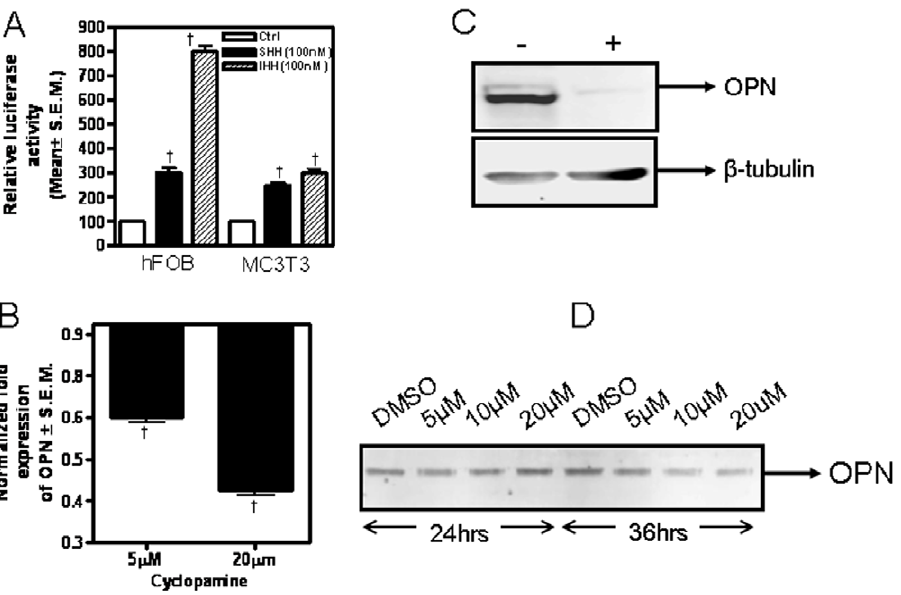
Figure 3. Hh signaling regulates OPN expression in osteoblastic cells. ( A ) Hh ligands significantly increase the activity of OPN promoter in the preosteoblastic cell lines hFOB 1.19 and MC3T3 E1 Sc-14 ( { indicates p , 0.0001 for all indicated groups). Cells were transfected with OPN promoter, treated with Hh ligands at the indicated concentrations and assessed for luciferase activity. ( B ) The Hh pathway inhibitor, cyclopamine (20 m g/ml), decreased the expression of OPN transcript ( { indicates p , 0.0001). hFOB 1.19 cells were treated with cyclopamine for 24 hours and assessed by quantitative real time RT-PCR for OPN expression. The expression of total OPN, from the cell lysate ( C ) as well as secreted OPN ( D ) is decreased in presence of cyclopamine. The decrease in the secreted OPN protein level is both, dose (5, 10 and 20 m M) and time dependent. hFOB 1.19 cells were treated with cyclopamine (20 m M for 24 hours; in panel C) and at theindicated concentrations and time intervals in panel D and assessed for expression of OPN by immunoblotting.